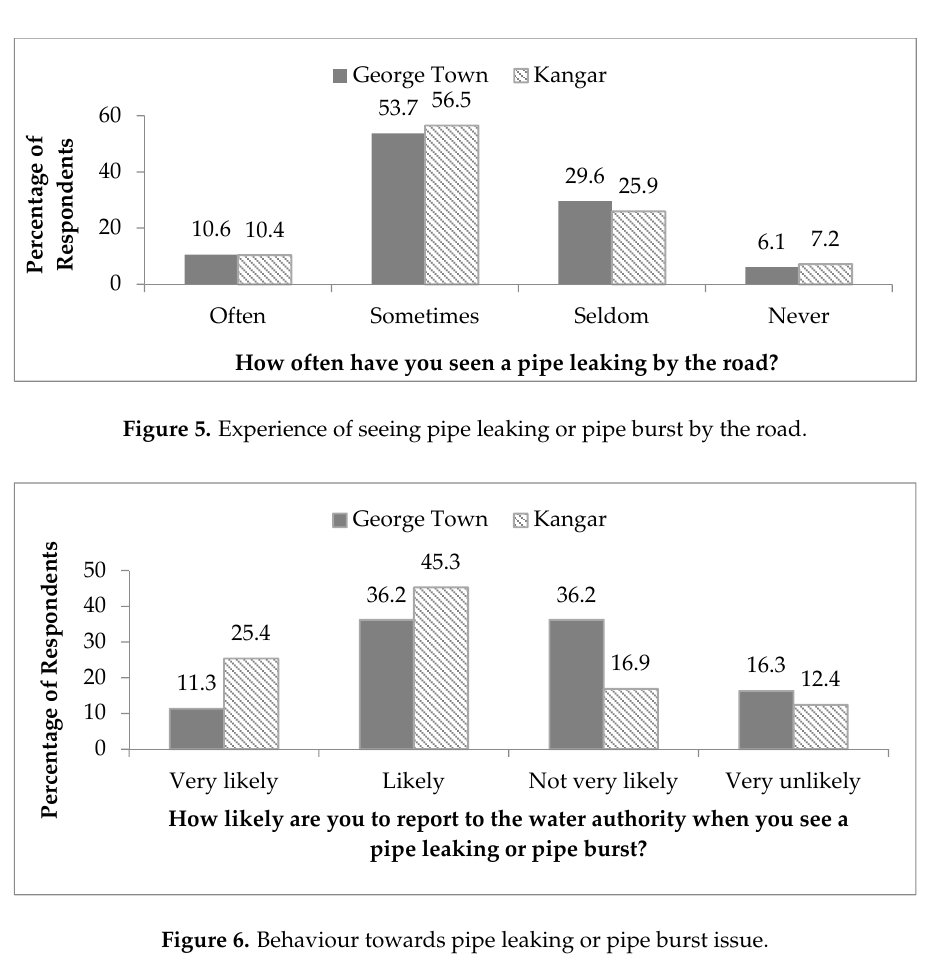
Figure 7. Percentage of respondents that saved phone number of water utilities in their mobile phone.